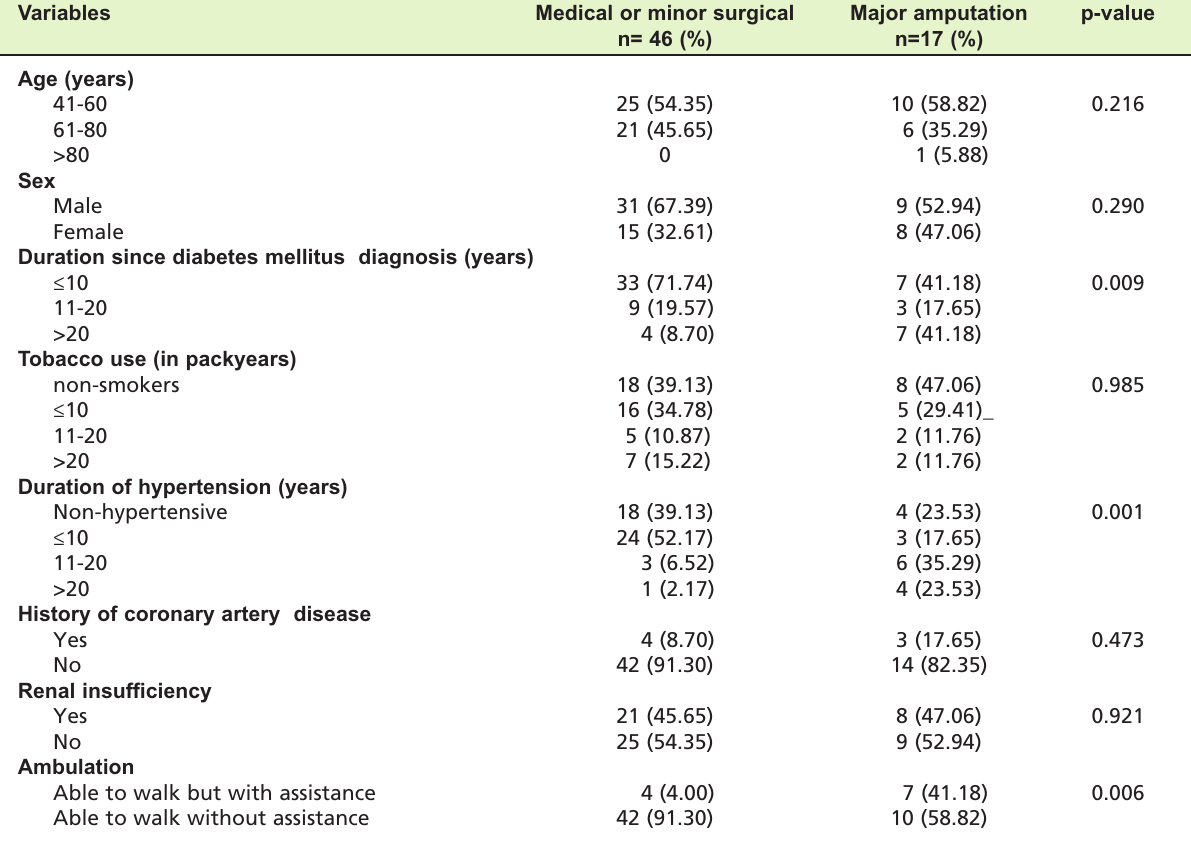
Clinico-demographic profile of participants (N=63) Table I: